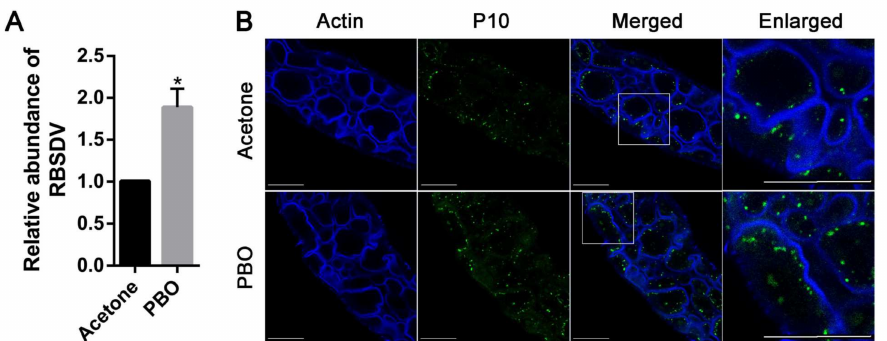
Figure 2. The effects of piperonyl butoxide (PBO) on RBSDV infection in its insect vector, L. striatellus . ( A ) RBSDV-infected L. striatellus was treated with PBO or acetone and, then, reared on rice seedlings for three days. The relative abundance of RBSDV was analyzed by calculating the expression of RBSDV S10 using RT-qPCR. The asterisk (*) indicates p < 0.05. ( B ) Midguts of L. striatellus treated with PBO or acetone were dissected, and RBSDV in the midgut was labeled by immunofluorescence analysis using antibodies raised against the outer capsid protein P10 of RBSDV. The cytoskeleton actin was labeled with phalloidin. The enlarged image shows the area in the square of the merged images. Scale bars, 50 µ m. Actin representing the cytoskeleton; P10 representing the outer capsid protein of RBSDV; merged representing the composite of Actin and P10; enlarged representing the zoom of the highlighted square area of the merged